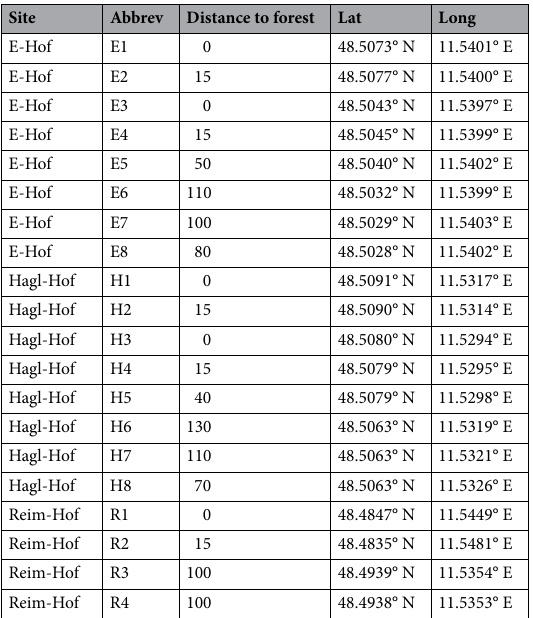
Table 1. Overview of all sampling sites. The corresponding farm, the abbreviation for the respective sampling point, distance to the forest edge, and the exact GPS coordinates are given.